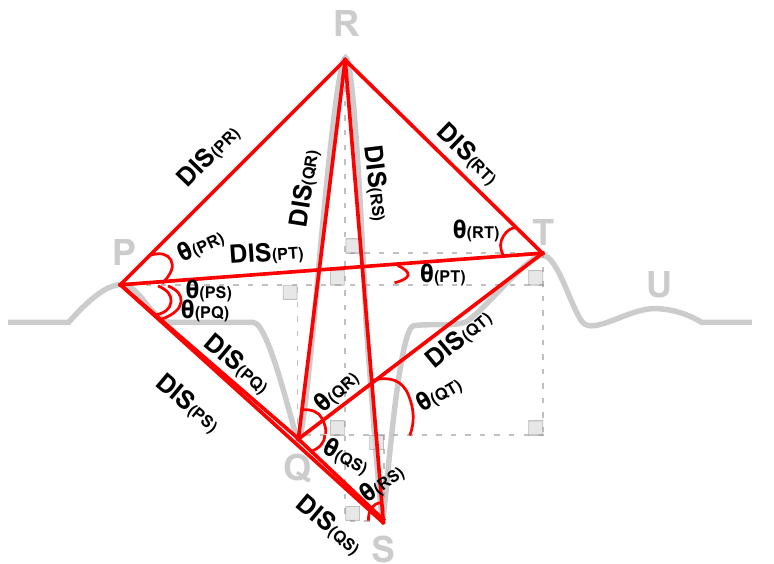
Figure 3. Features extracted from an ECG